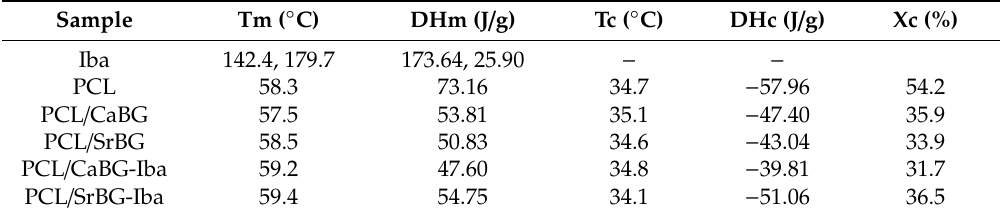
Table 2. Thermal properties of PCL and its composite thin